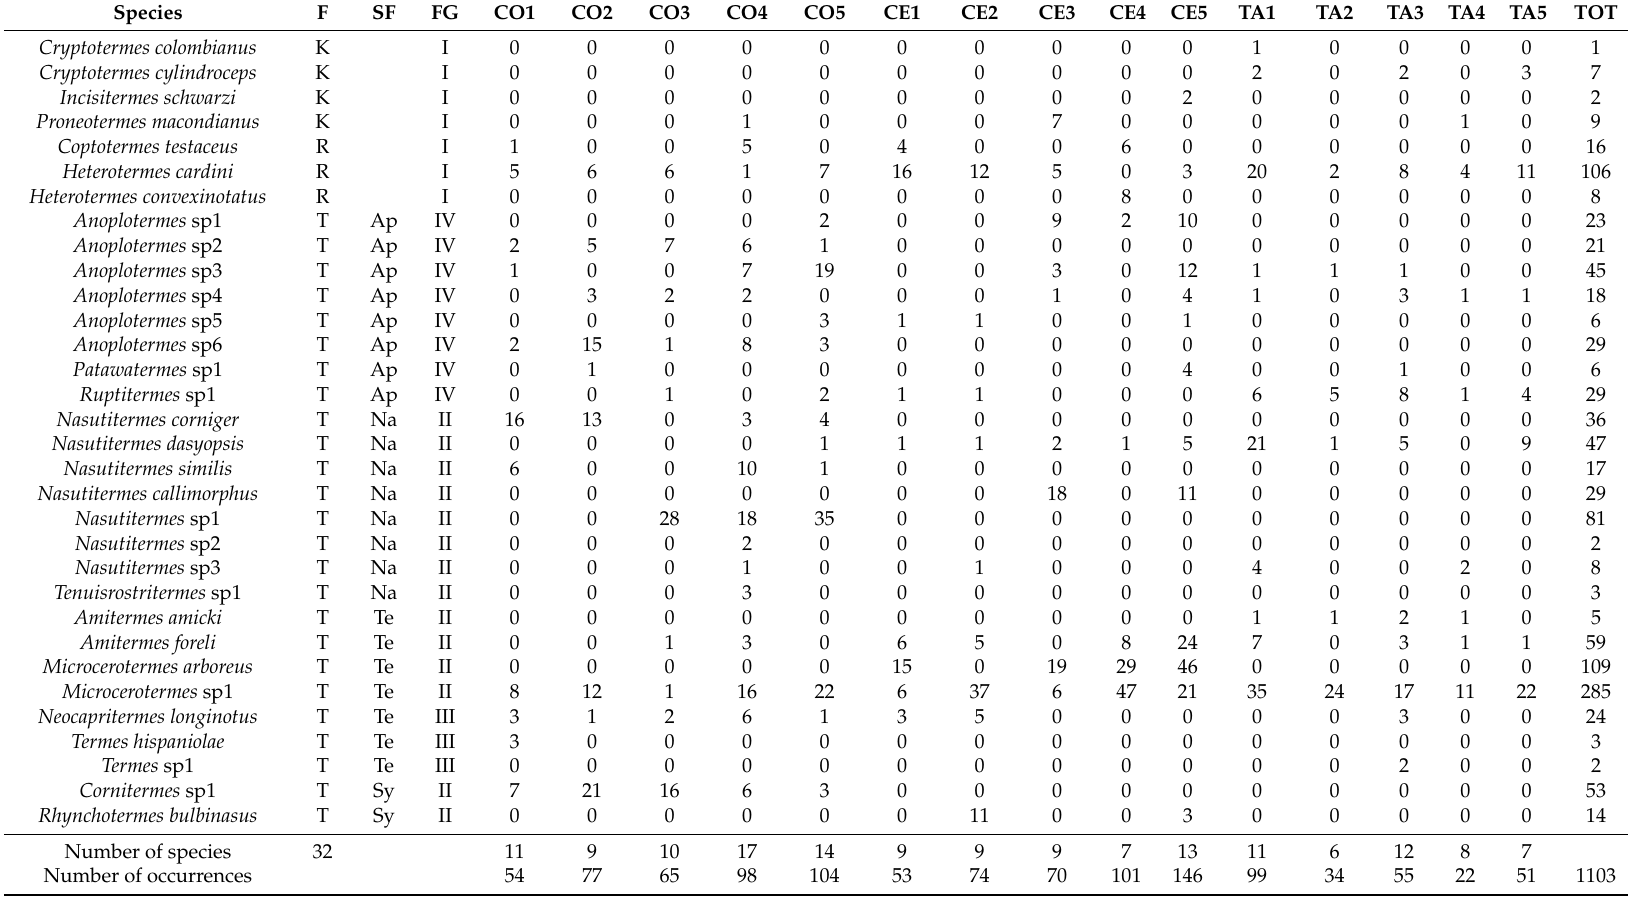
Table A2. Occurrences of termites per study plot (100